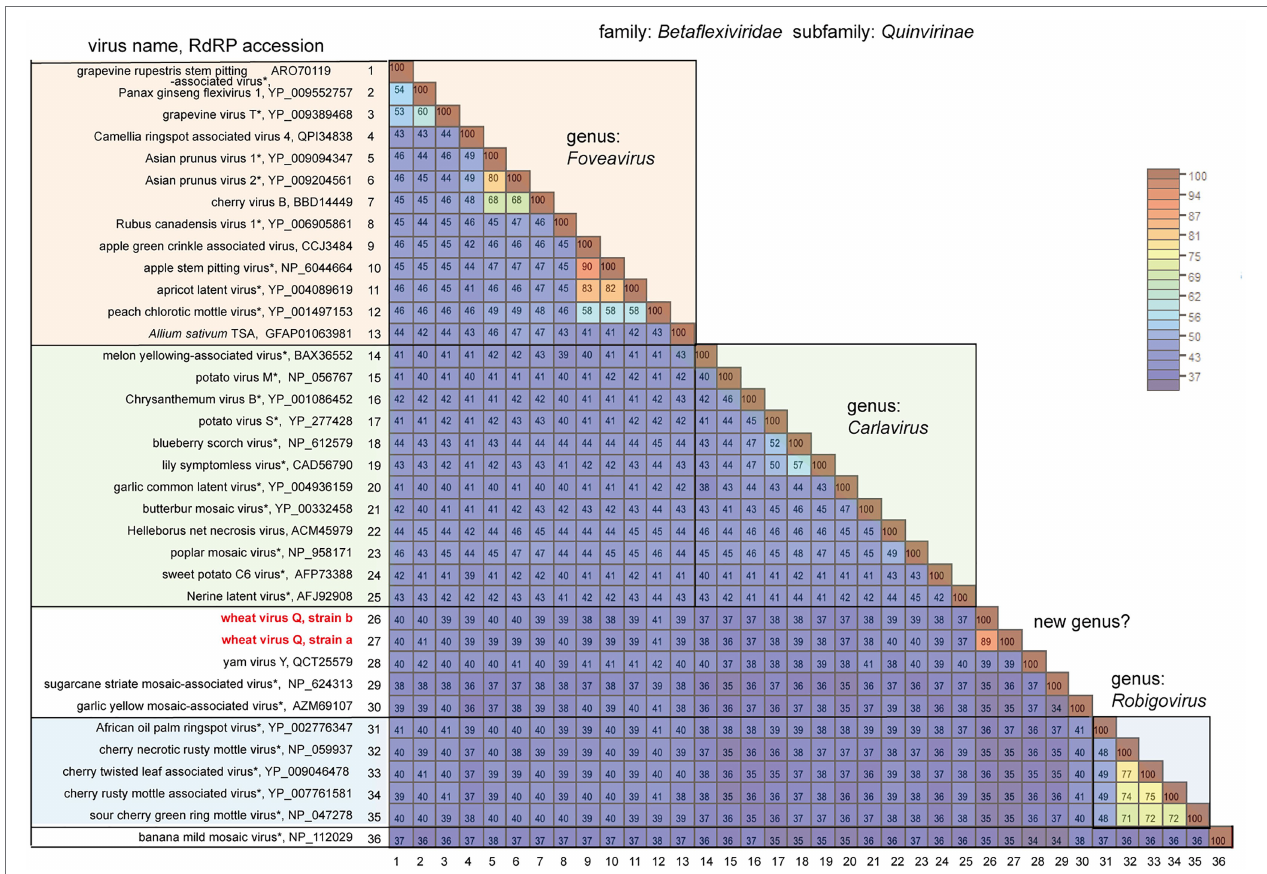
FIGURE 3 | Pairwise comparison of the replicase (RdRP) encoded by quinviruses or their candidates. The results of pairwise comparisons are shown as a heatmap with each pairwise amino acid identity calculated using SDT ver. 1.2. The virus names with asterisks are representative members of the viral